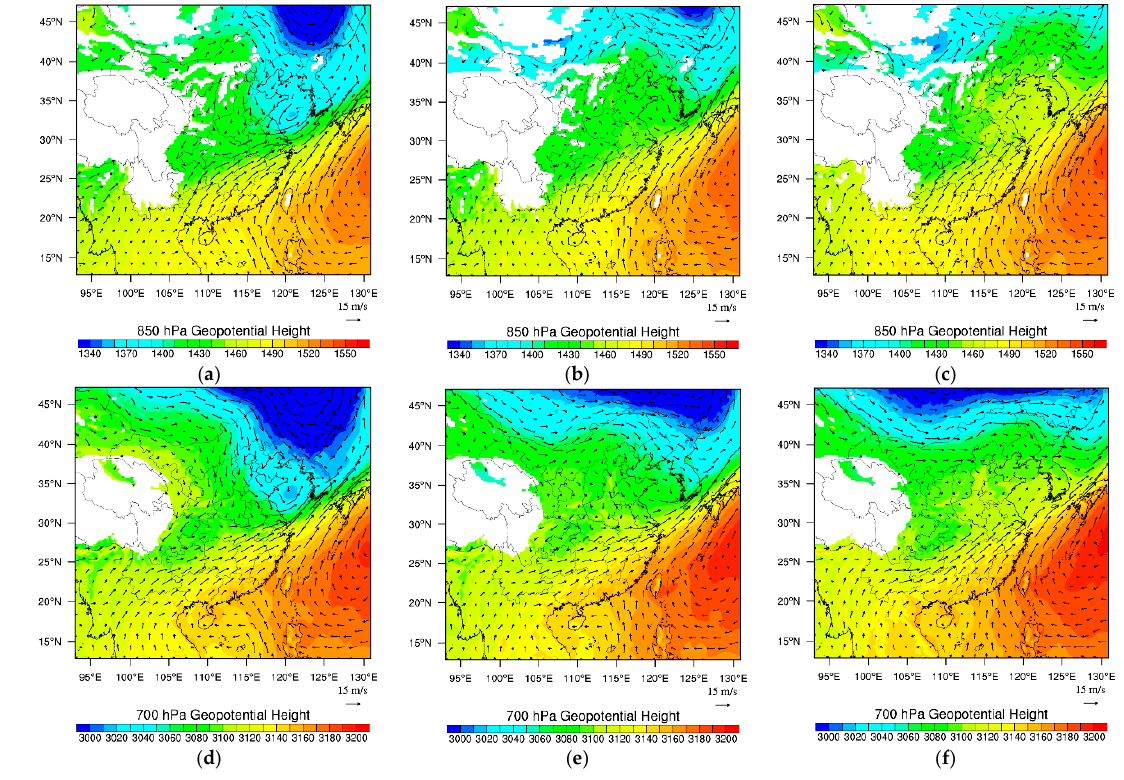
Figure 4. Wind field (vector; m/s) and geo-potential height (shaded; geo-potential metre) of GFS analysis at 850 hPa ( a – c ), and 700 hPa ( d – f ) from 0000 UTC 05 to 0000 UTC 06 July 2013 at an interval of 12 h.